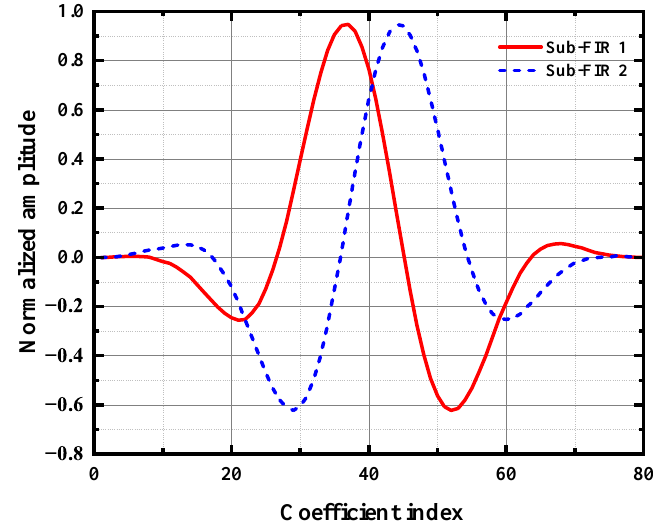
Figure 2. Impulse response of two sub-FIR